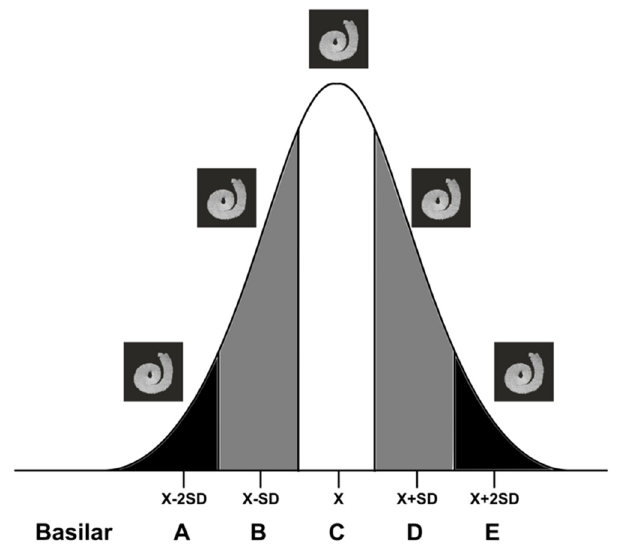
Figure 3. Five “basilar membrane” templates selected according to the normal distribution of each index—(A) × H 360 , (A × B) × H 360 , and (A/B) × H 360 —on 100 CT images from pre-implanted index—(A)×H 360 , (A×B)×H 360 , and (A/B)×H 360 —on 100 CT images from pre-implanted patients.